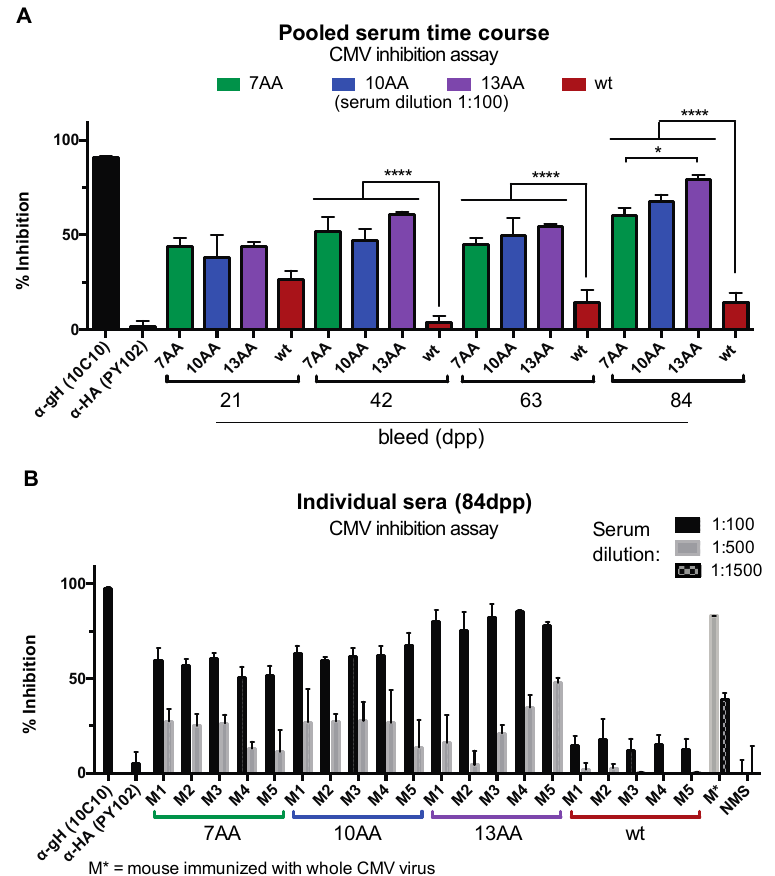
Figure 5. Chimera influenza / CMV viruses generate a CMV inhibition antibody response. ( A ) Pooled serum from each immunization group was analyzed in a CMV inhibition assay with the infection of AD169 BADrUL131 (MOI: 0.5) pre-incubated with serum (1:100) in ARPE-19 cells. Cell infection was analyzed at 24 h post-infection using the Celigo fluorescence cytometer. Anti-CMV gH monoclonal antibody (mAb) (10C10) (2 µ g / mL) and PR8 head specific mAb (PY102) (2 µ g / mL) were utilized as positive and negative controls, respectively. ( B ) Serum from individual mice at 84 days post prime (dpp) was subjected to a CMV inhibition assay with infection of AD169 BADrUL131 (MOI: 0.5) pre-incubated (1:100 and 1:500) with sera at specified dilutions in ARPE-19 cells. Pre-incubation with serum from a mouse immunized with the whole CMV (TB40 / E) virus (M*) (1:500 and 1:1500), normal mouse serum (NMS) (1:100 and 1:500), and mAbs 10C10 and PY102 (2 µ g / mL) were utilized as controls. The % inhibition was determined using NMS as 0% inhibition and no infected cells as 100% inhibition. Experiments were performed in technical replicates with the s.d. being depicted. * p < 0.05, **** p < 0.0001 (ANOVA).